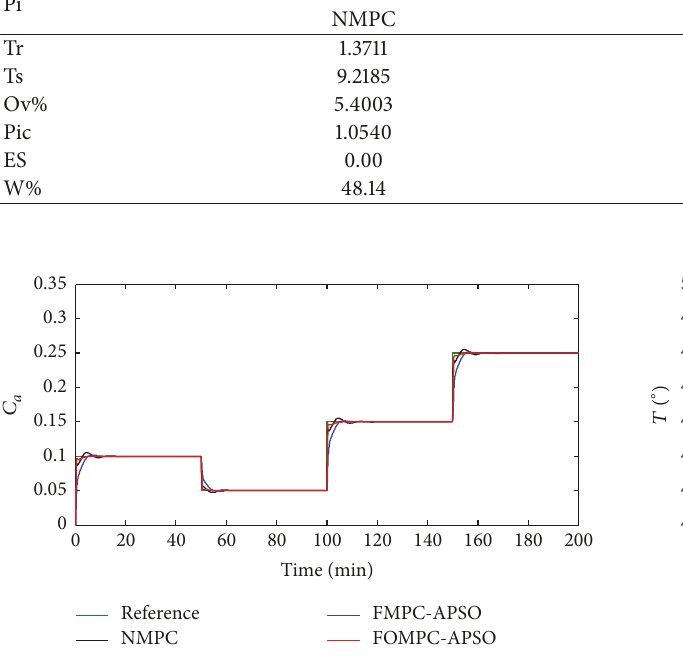
Figure 6: Evolution of concentration 𝐶𝑎 . Figure 7: Evolution of temperature 𝑇